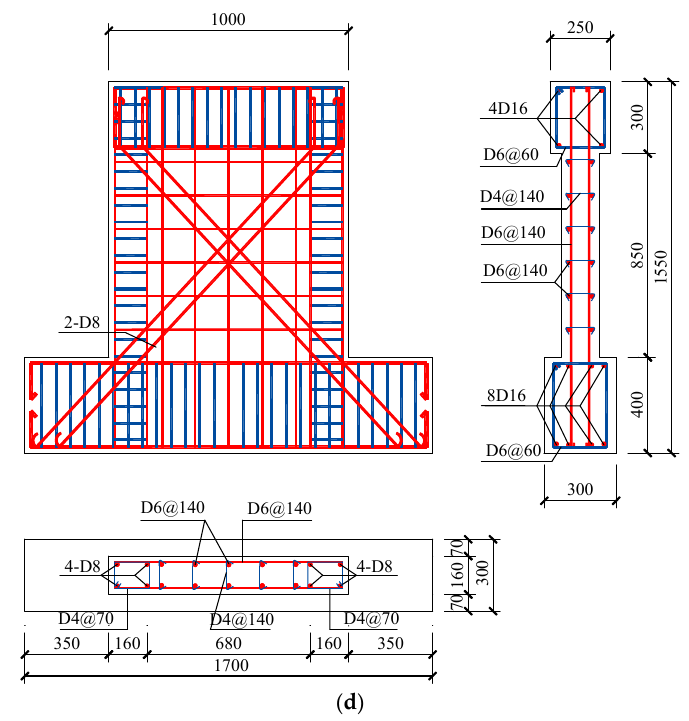
Figure 4. Specimen details. ( a ) Specimens W1, W2, W3, W4 and W5; ( b ) Specimen W6; ( c ) Specimen W7; ( d ) Specimen W8.